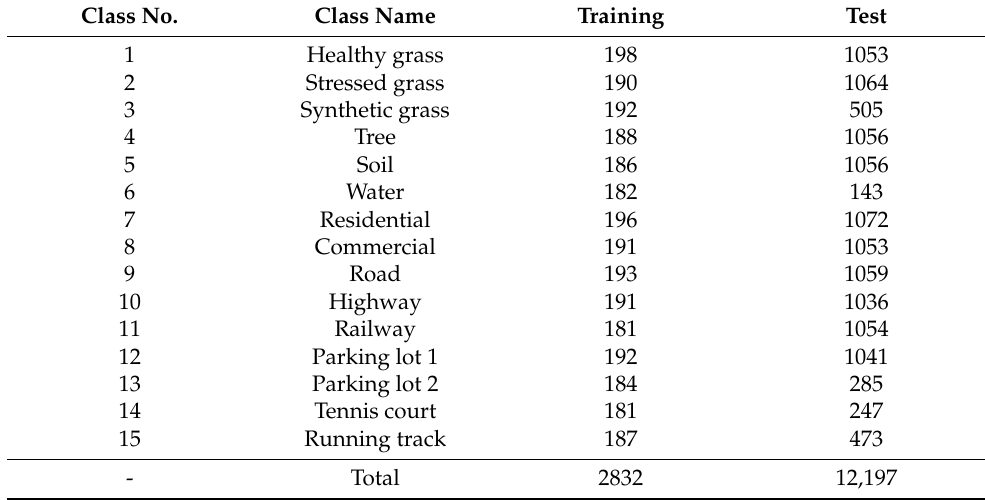
Table 1. Sample distribution of the Houston 2013 dataset.